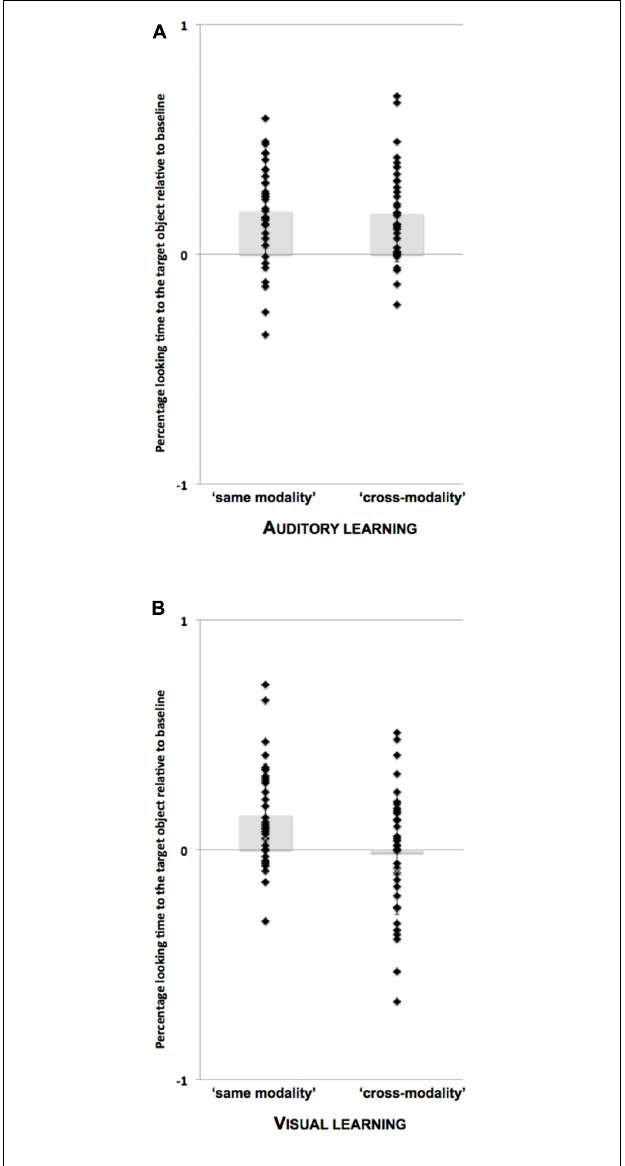
FIGURE 3 | Mean proportion of target-looking times [Target/(Target + Distractor)] after adjusting for baseline preferences (post-naming period minus pre-naming period). Positive values indicate greater looking at the target object rather than the distractor upon naming. Individual data points are overlaid on group means for the auditory learning group (A) and the visual learning group (B) in the two ‘same modality’ and the two ‘cross-modality’ test trials. Each participant contributes to at least one data point in each test condition (‘same modality’ vs. ‘cross-modality’). This makes a total of 66 observations for the auditory learning group (same modality: 34/42, cross-modality: 34/42) and 69 observations for the visual learning group (same modality: 35/38, cross-modality: 34/38). Error bars represent the standard deviation from the mean.